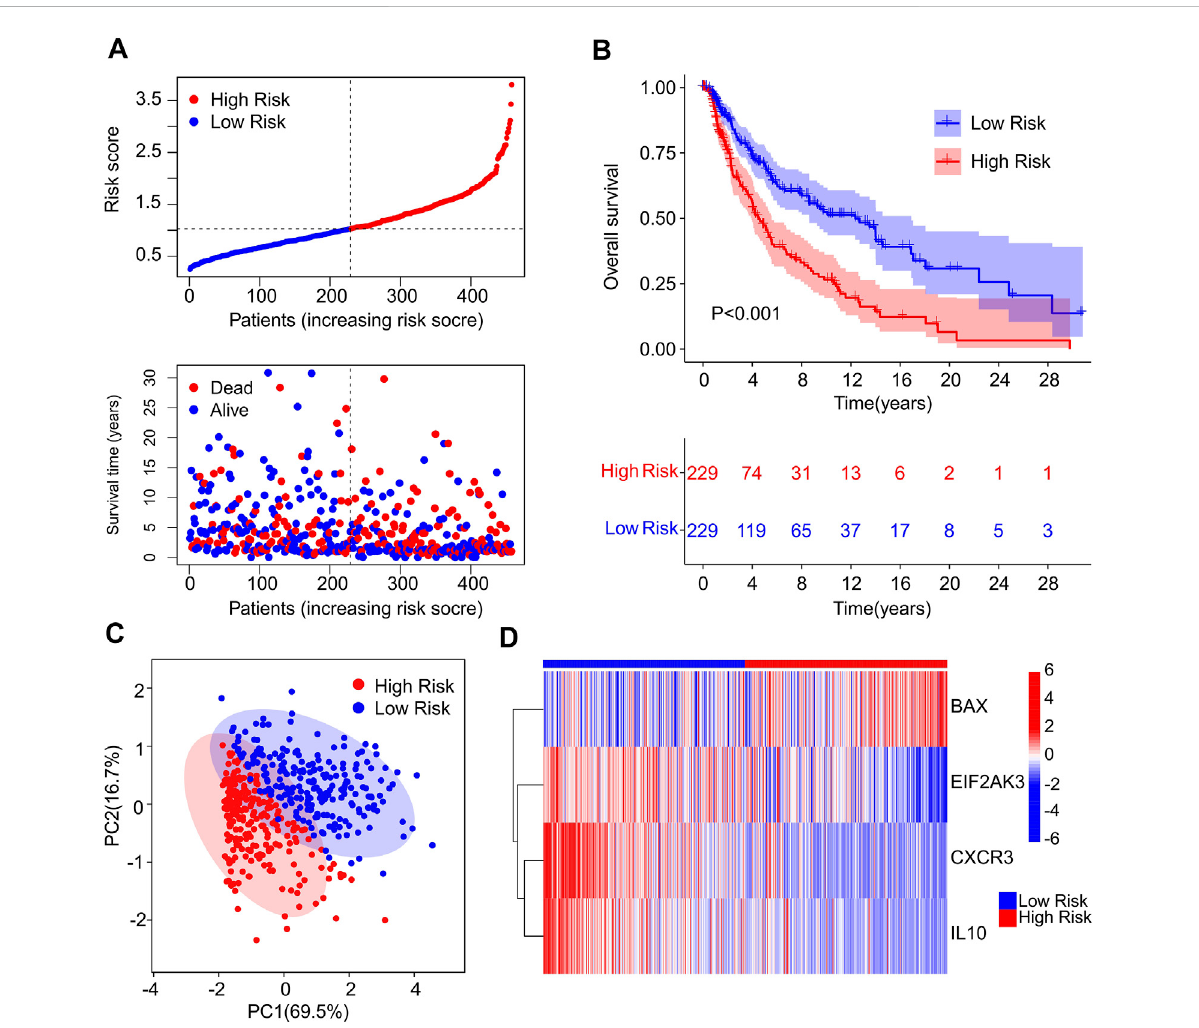
FIGURE 2 Construction of risk model based on the prognostic ICD genes of patients with CM. (A) Distribution of risk score of CM patients and scatter dot plot shows the correlation of risk score and survival time. (B) The Kaplan-Meier survival curve shows that the OS of low-risk group was signi fi cantly higher than high-risk group. (C) Principal component analysis (PCA) shows a signi fi cant difference in high- and low-risk group based on the four prognostic ICD genes. (D) Heatmap illustrates the expression of four prognostic ICD genes ( BAX, EIF2AK3, CXCR3 and IL-10 in high- and low- risk